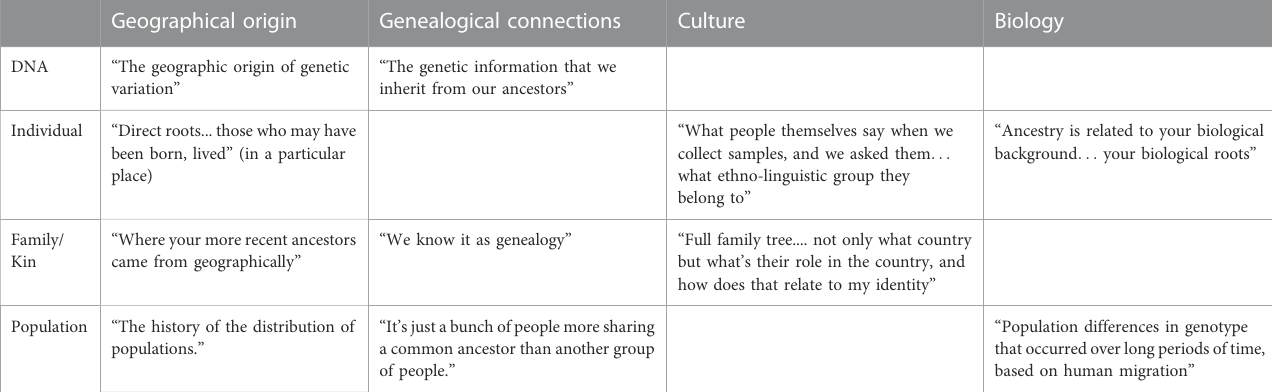
TABLE2Categorizingthede fi nitionsofancestryofferedbyresearcherswhoseworkcloselyengagestheconceptbya)whatancestryisapropertyof,andb)thecriteria by which individuals share ancestry.